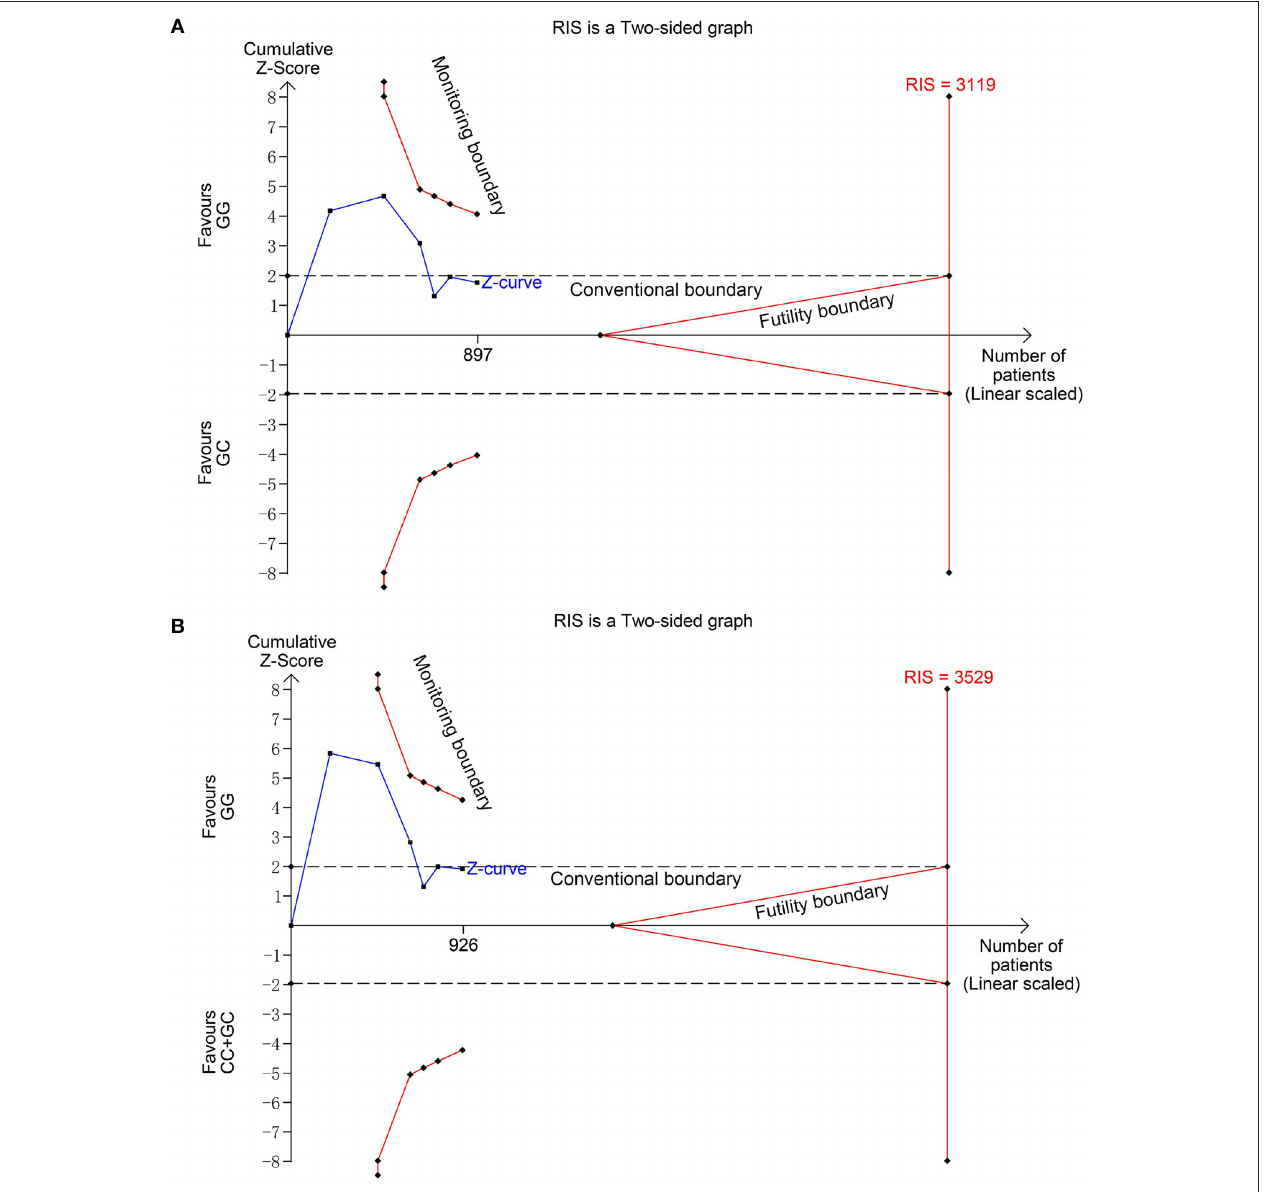
FIGURE 4 | Trial sequential analysis for the association between MIF -173G > C polymorphism and steroid responsiveness under the heterozygous (A) and dominant (B) models. The required information size (RIS) was calculated based on α = 5%, 80% power, and a relative risk reduction of 20%. The cumulative Z-curves did not cross monitoring and futility boundaries and also did not reach the RIS in (A) and (B) , indicating the results were inconclusive and more studies were